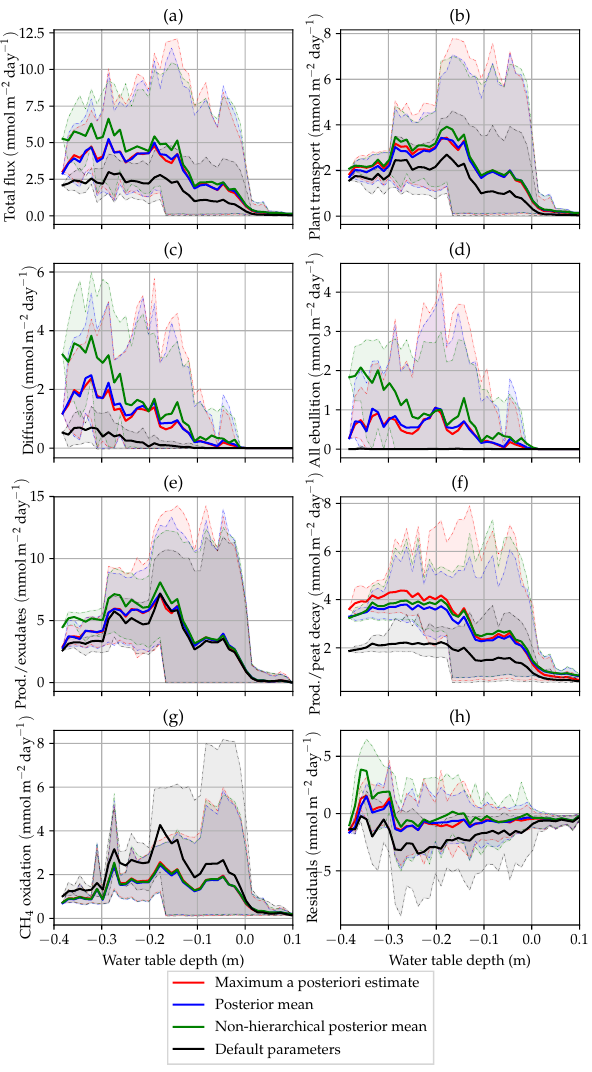
Figure 11. Means of total CH 4 emission (a) , its components (b–c) , total ebullition taking place (d) , CH 4 production (e–f) , CH 4 oxida- tion (g) , and model residuals (h) as functions of water table depth. Shaded areas show the 5th and 95th percentiles. To look at the effect of the optimization, compare the black and the blue/red